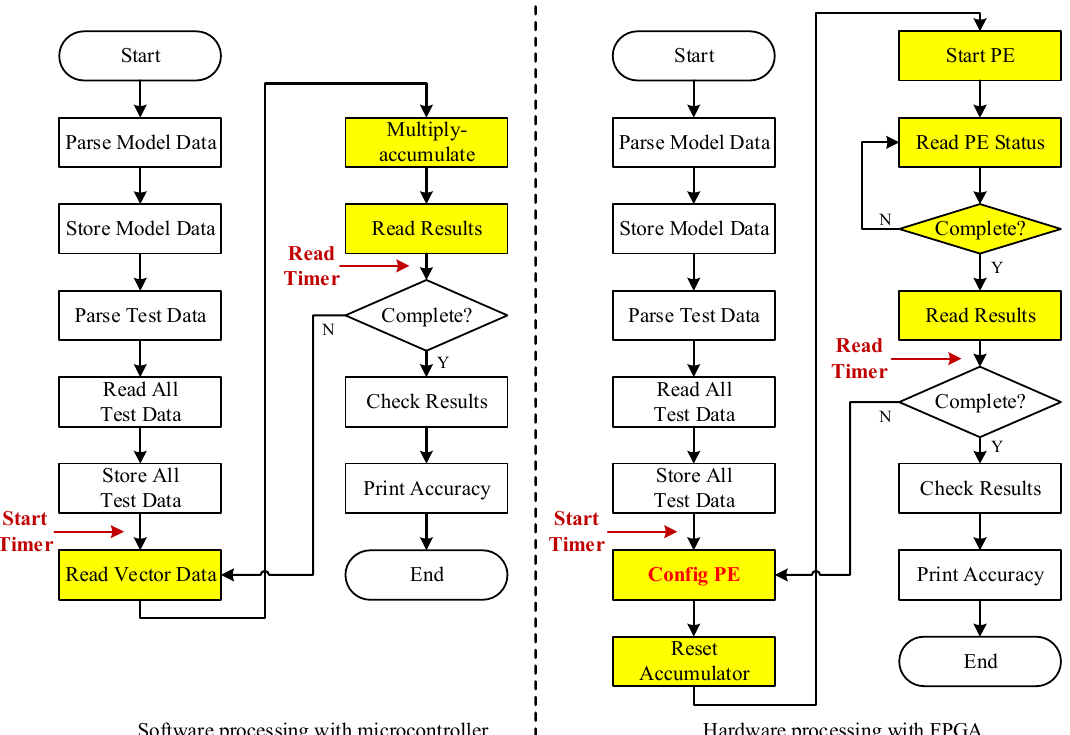
Figure 3. Software flowchart.